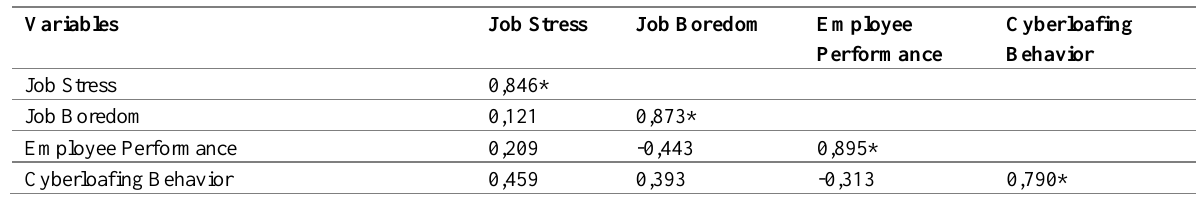
Table 4: Discriminant Validity